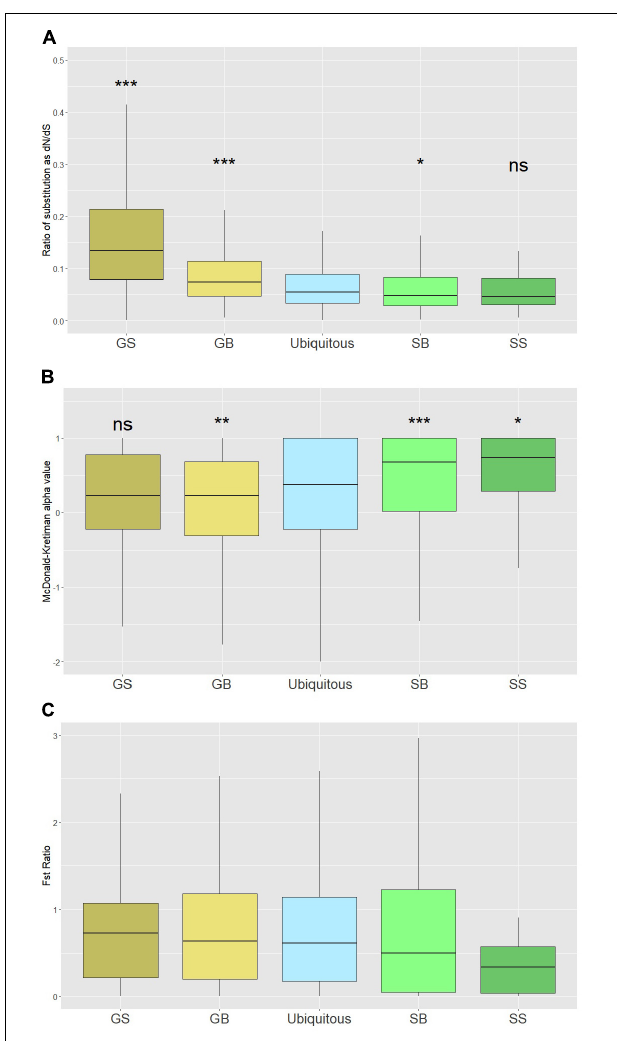
FIGURE 4 | Measurements of sequence evolution and positive selection: (A) Rate of sequence evolution measured by dN/dS between Macrocystis pyrifera and Ectocarpus siliculosus coding regions for each category of gene expression. (B) Proportion of substitutions that were the result of positive selection measured as alpha in a McDonald–Kreitman test. Negative alpha values can be the result of slightly deleterious mutations segregating. (C) Ratio of 1st and 2nd F ST to 3rd F ST indicating purifying selection on sporophyte-specific genes. GB, gametophyte-biased; GS, gametophyte specific; SB, sporophyte-based; SS, sporophyte specific. (pairwise Wilcoxon test; *** p -value < 0.001; ** p -value < 0.01; * p -value <